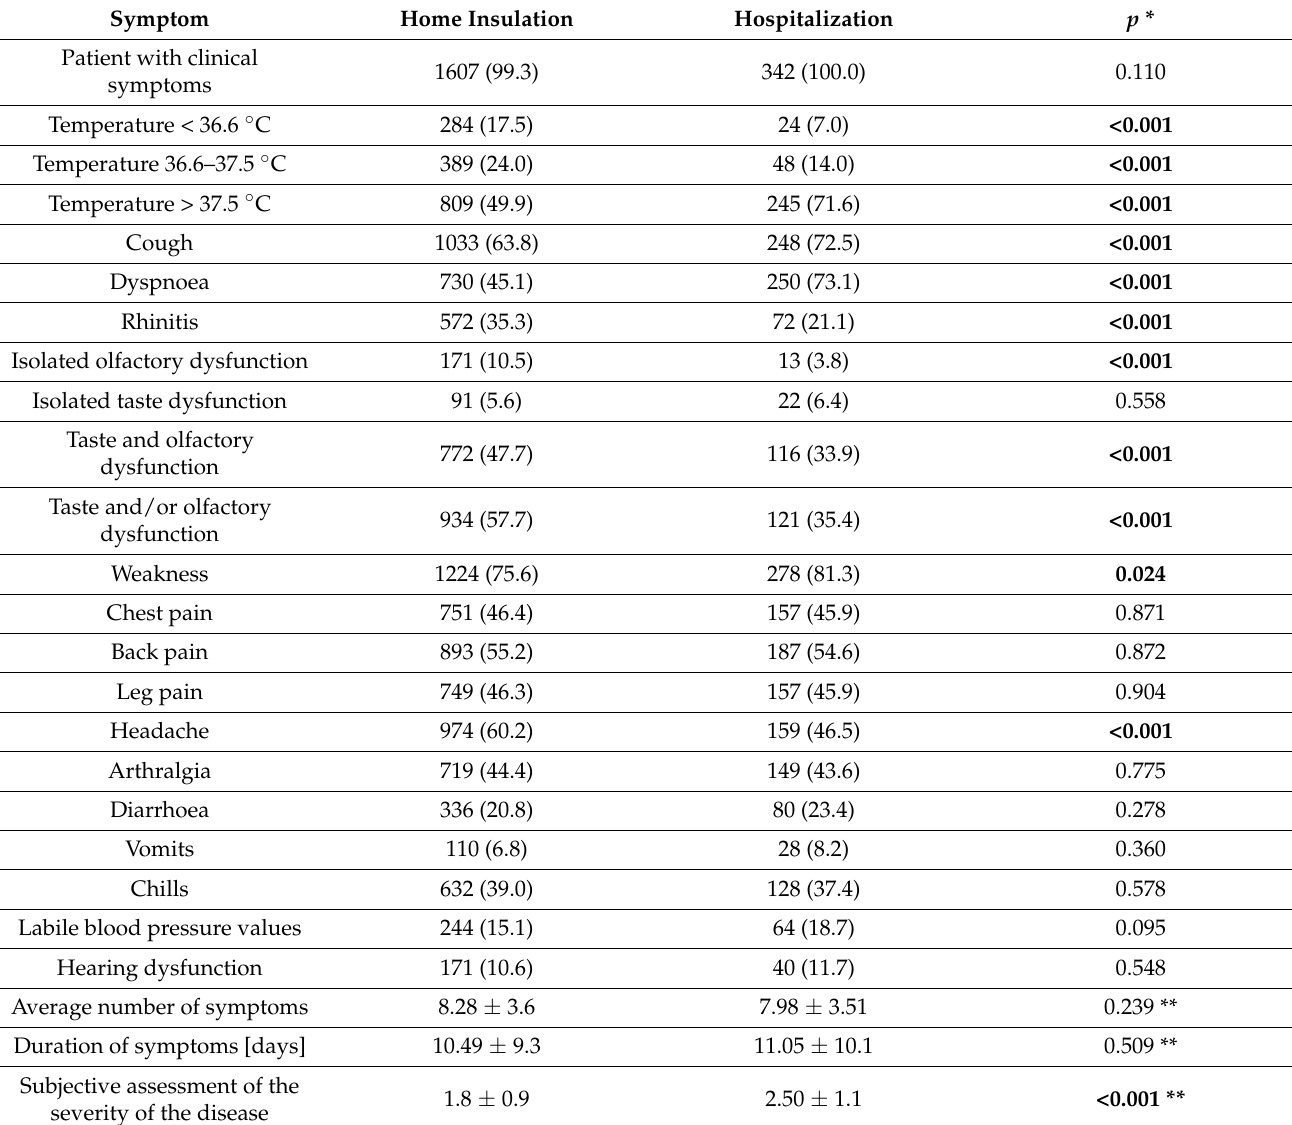
Table 3. Comparison of the clinical picture between hospitalized patients and patients staying in home isolation in the course of